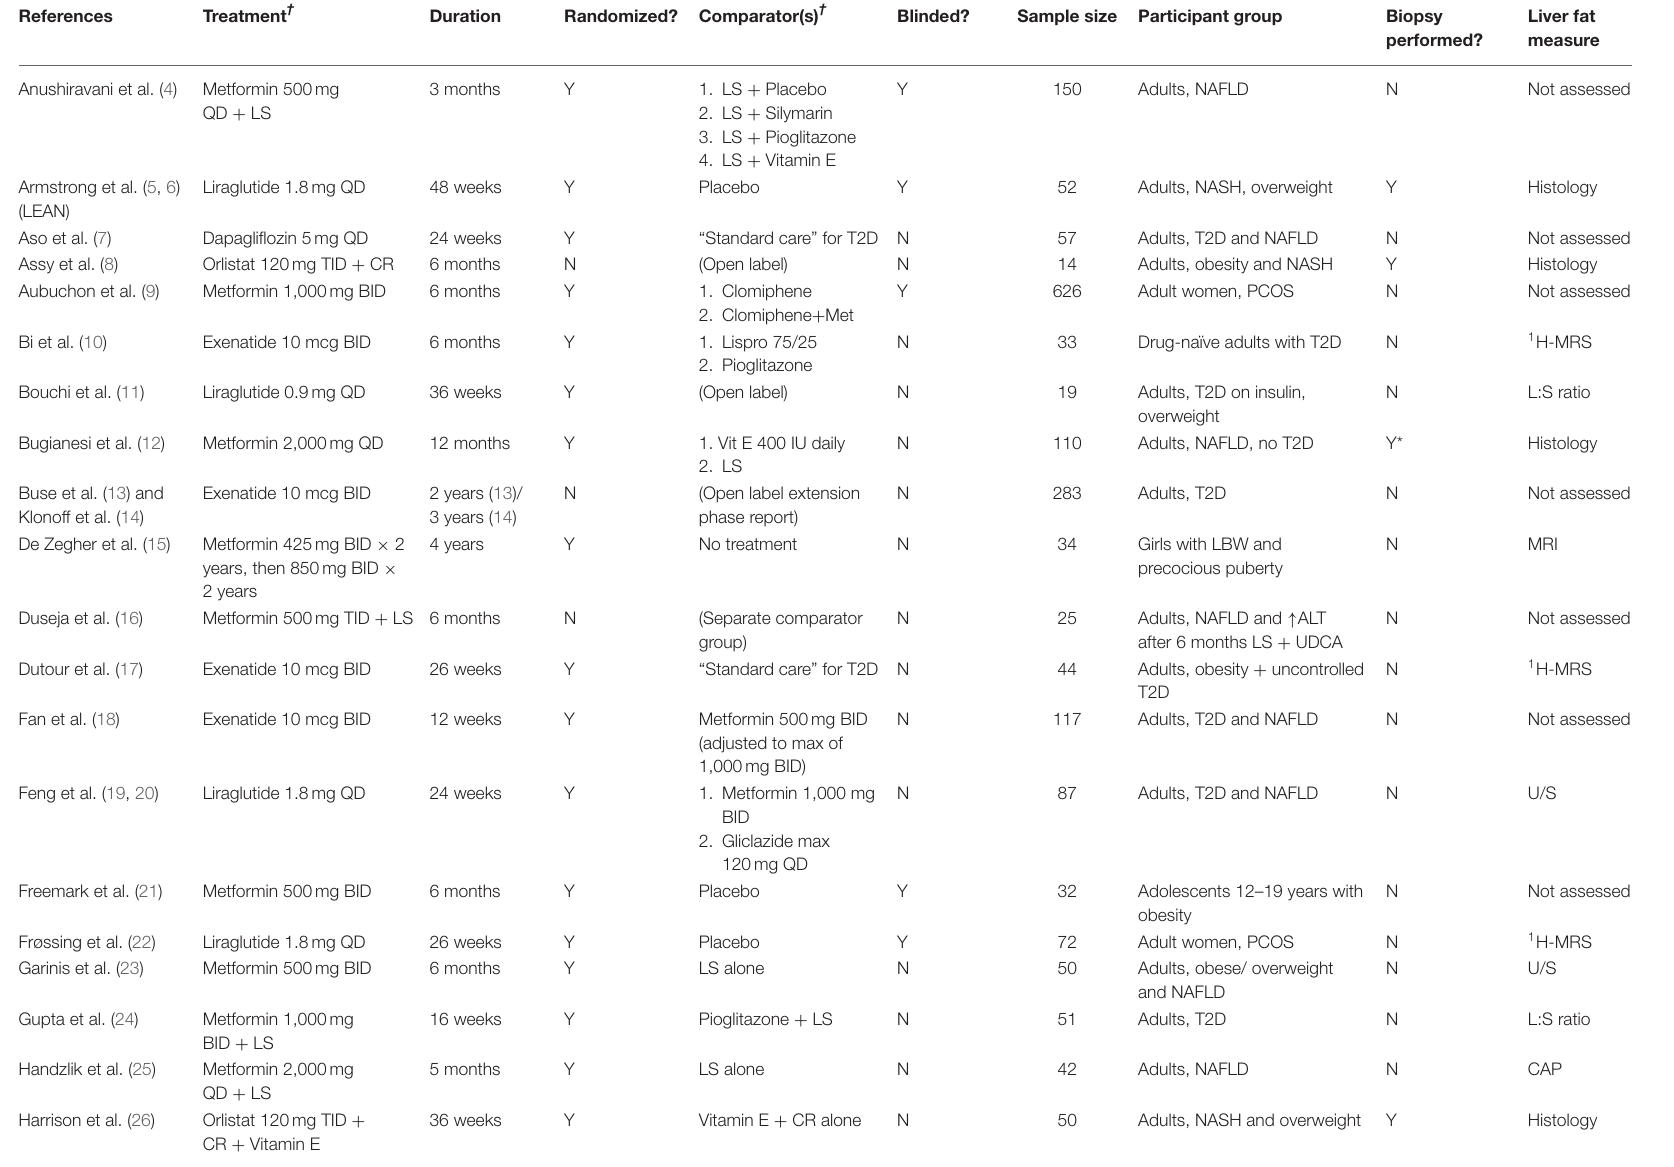
TABLE 1 | Characteristics of studies